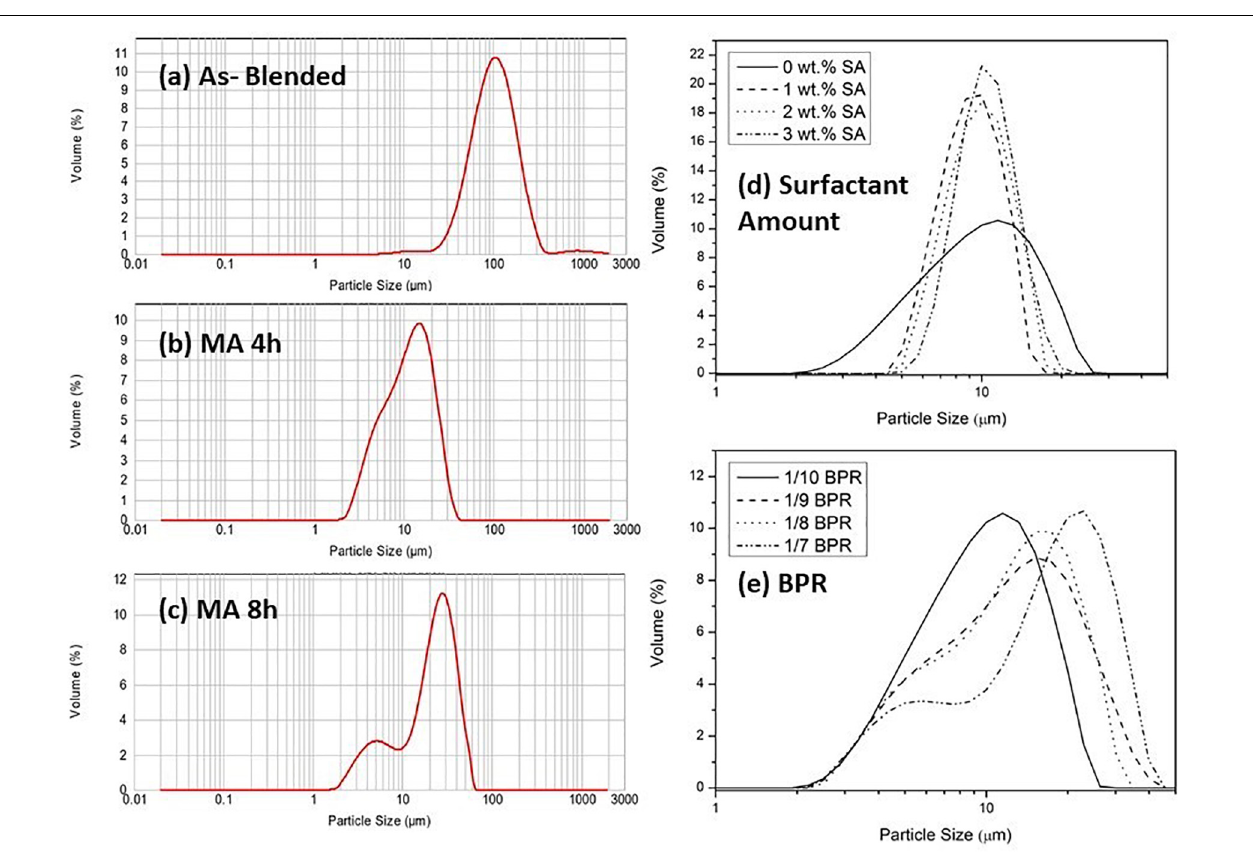
(Söyler et al., 2010). The effects of ball to powder ratio (BPR), within 10:1 to 7:1 range and amount of surfactant (stearic acid, SA), between 0 and 3% range, were also studied for Fe-14Mn- 6Si-9Cr-5Ni, at constant MA time of 4 h